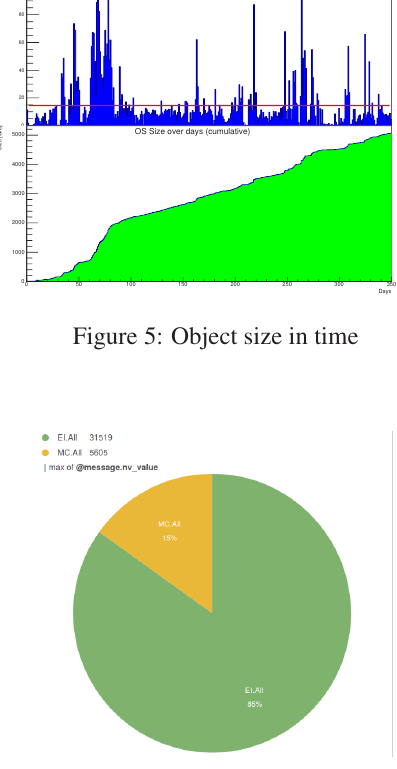
Figure 6: Objects size histogram Figure 7: Hadoop(HDFS) storage